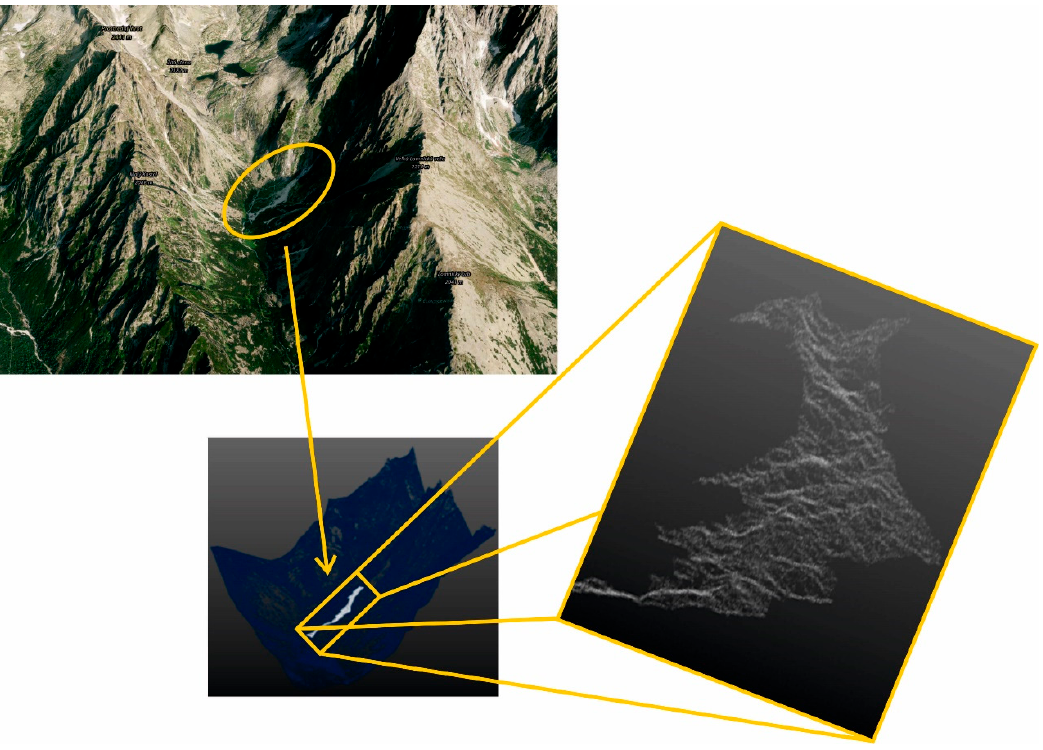
Figure 13. ALS point cloud.